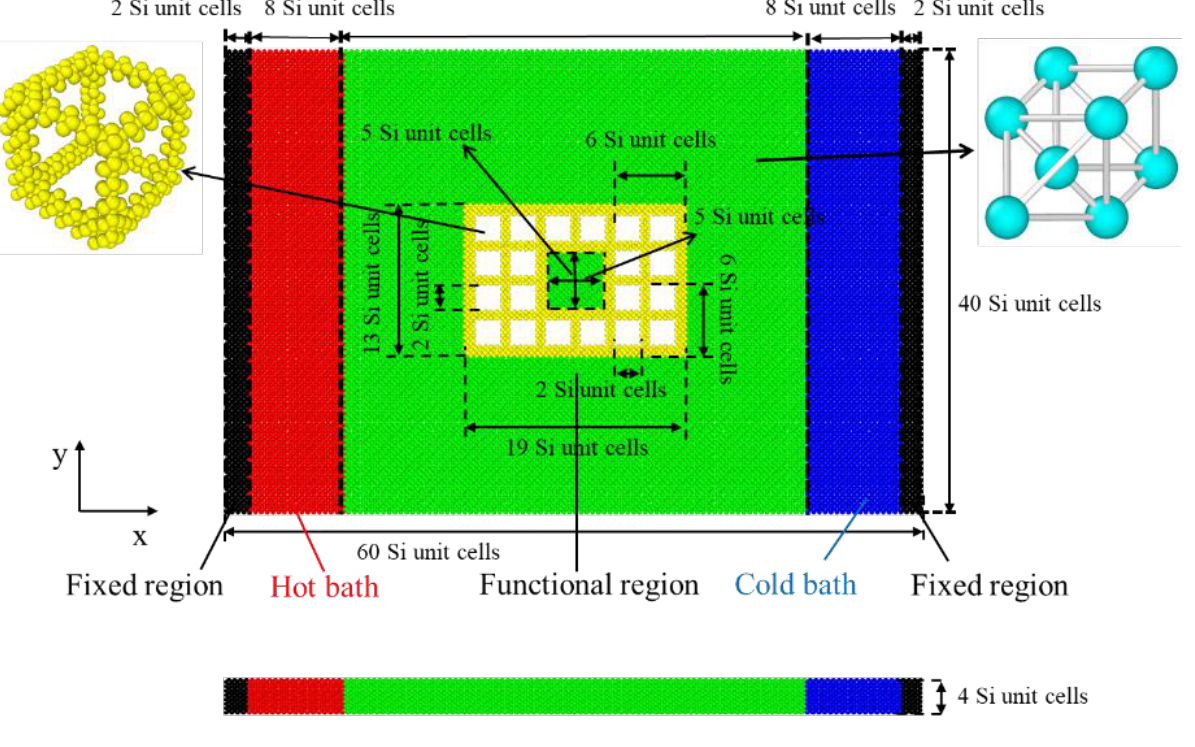
Figure 3. Schematic diagram of each region of the nanocloak.